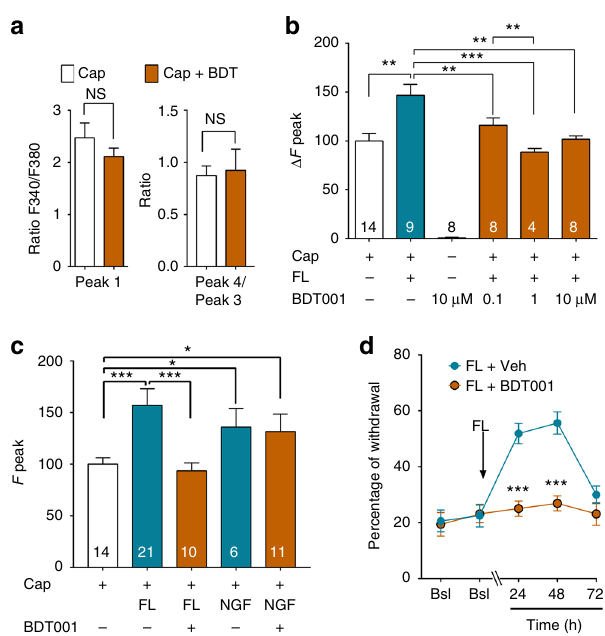
Fig. 7 BDT001 inhibited FL-induced TRPV1 potentiation in DRG neurons in vitro and FL- induced pain symptoms in vivo. a In the absence of FL, BDT001 (10 µ M), did not inhibit capsaicin (Cap)-induced increases in [Ca 2 + ] i levels, in a protocol identical to that described in Fig. 2a. Results are means ± s.e.m. of data from 9 neurons. Unpaired Student ’ s t -test. b BDT001 inhibited potentiation by FL (0.056 nM) of capsaicin-induced increases in [Ca 2 + ] i levels in a concentration-dependent manner, but had no effect alone on [Ca 2 + ] i levels. c BDT001 (10 µ M), inhibited potentiation by FL (0.056 nM), but not NGF (10 nM) of capsaicin-induced increases in [Ca 2 + ] i levels. In b , c , results are means ± s.e.m. of data obtained from the number of neurons indicated in columns and are expressed as response amplitudes normalized to capsaicin (0.5 µ M) alone ( Δ F peak). Unpaired Student ’ s t -test, * P < 0.05; ** P < 0.01; *** P < 0.001. d BDT001 (5 mg/kg i.p.) inhibited mechanical pain hypersensitivity induced by FL (50 ng/10 µ l, injected intrathecally). Bsl basal scores before FL injection. Results are means ± s.e.m. of data from 8 animals per group. One-way ANOVA with repeated measures and Dunnett ’ s test, * P < 0.05; ** P <